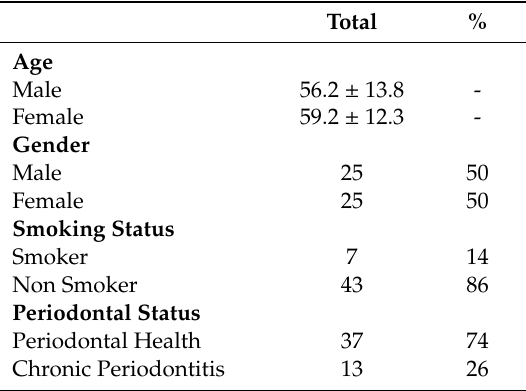
Table 1. Characteristics of the included